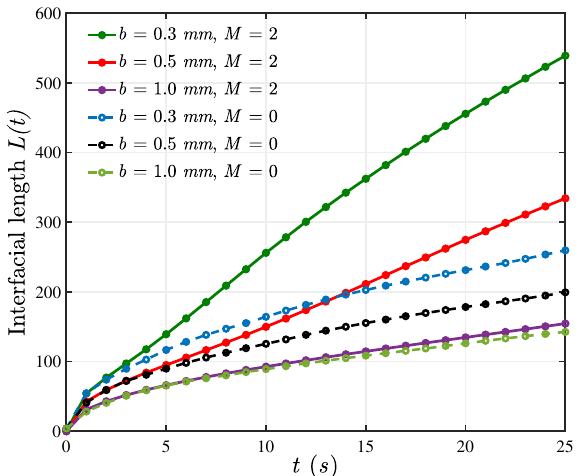
Figure 7. Interfacial length plots for U = 10 mm/s, M = 2 and M = 0 for various gaps.